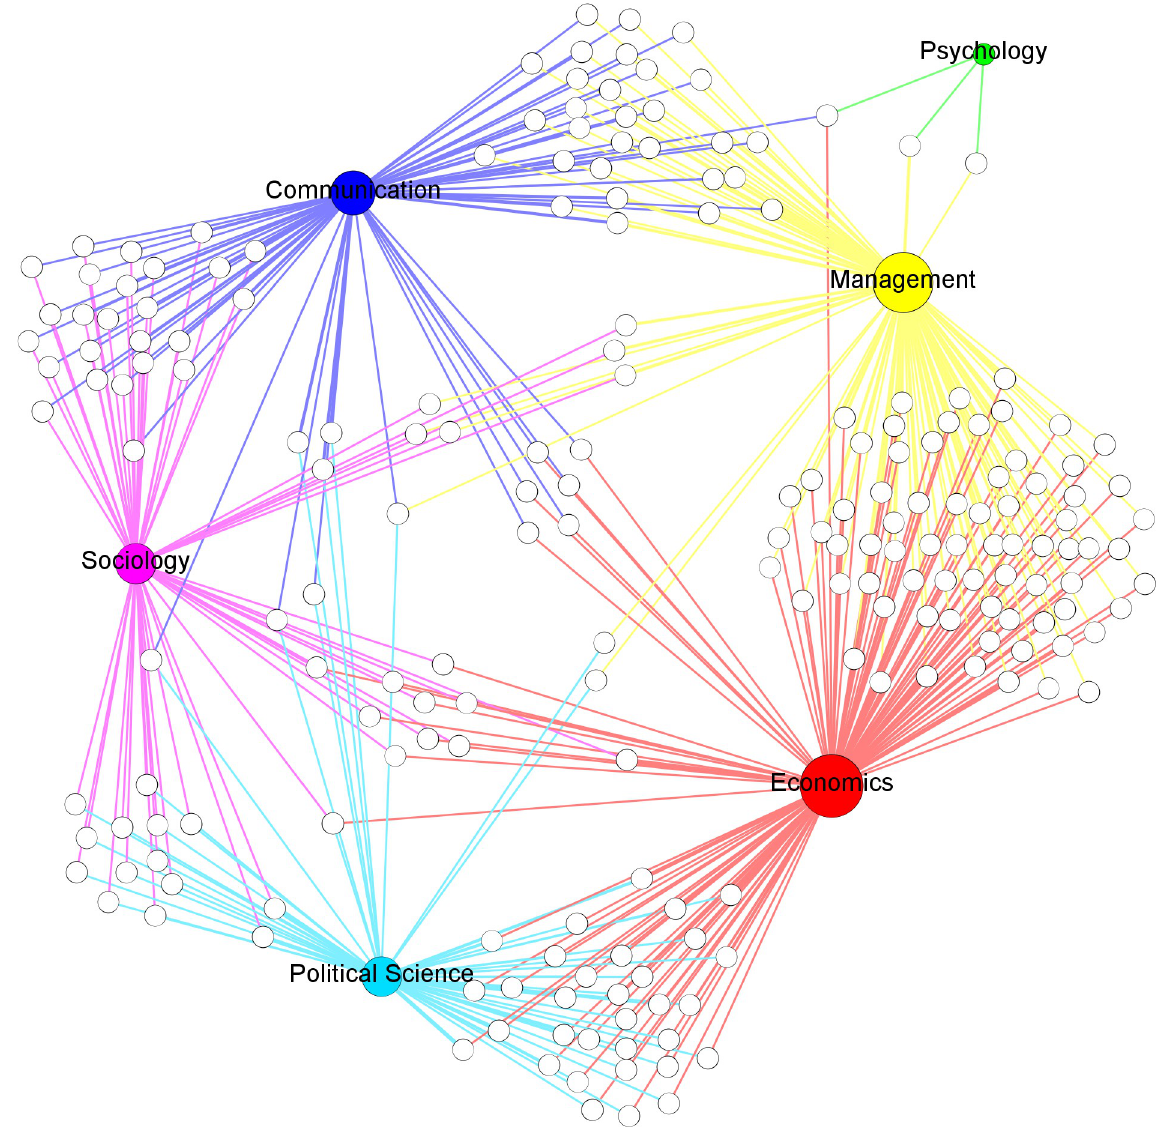
Fig 3. Connections between fields through EBIs. White nodes represent scholars who act as members of EBs in journals of more than one field. Size of field nodes is proportional to degree (number of interdisciplinary scholars).